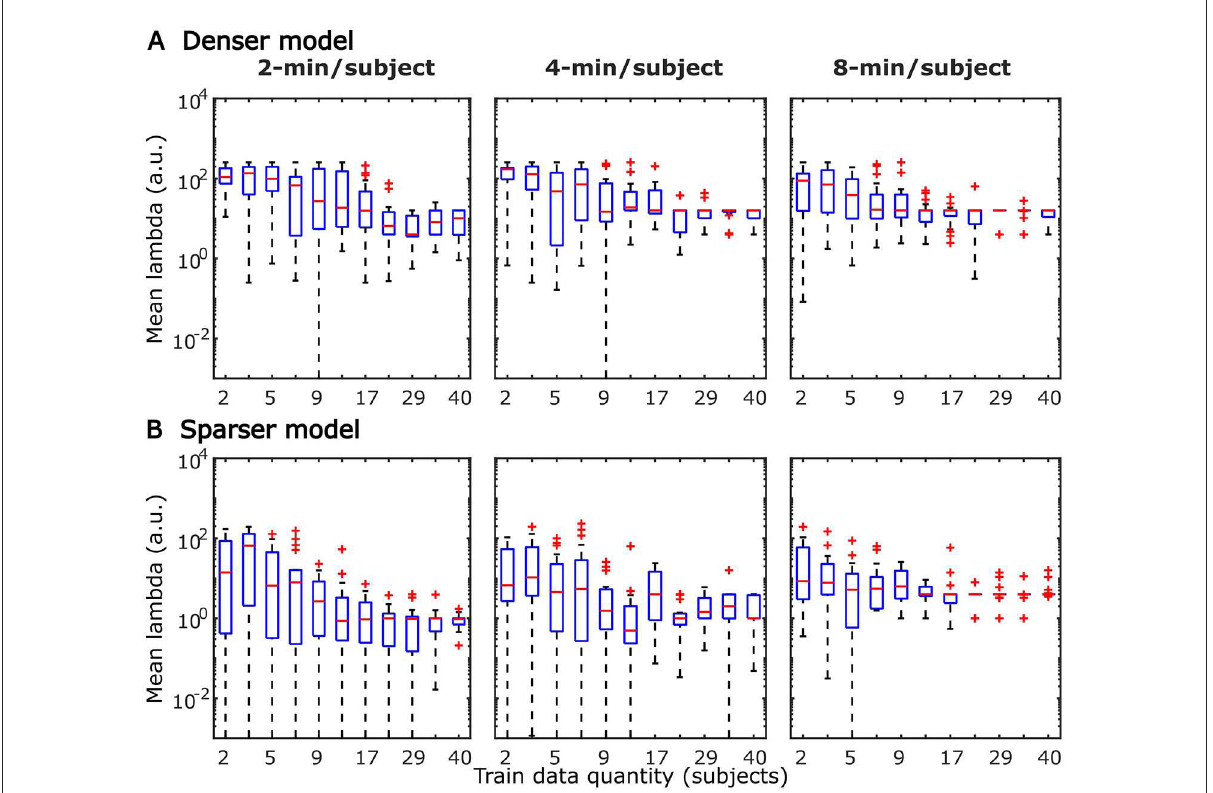
FIGURE14 Distributions of generic model regularization parameters, lambda, from the denser (A) and sparser (B) models, as a function of training data quantity. Details of visualization are as in Figure 6.